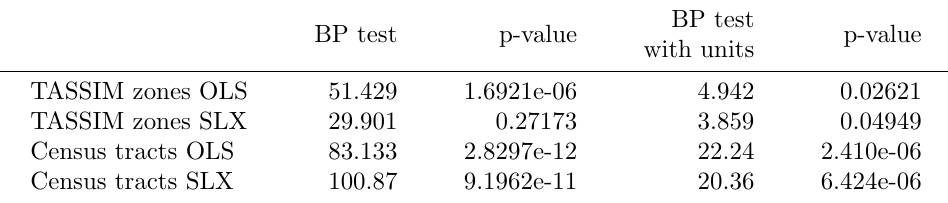
Figure A.5: Histograms of the distributions of counts of owner-occupied one-family housing units by observational unit; panel (a) observational units 506 Census tracts and panel (b) 96 approximate TASSIM zones. Table A.6: Studentized Breuch-Pagan tests for heteroskedasticity for models fitted by least squares for the 489 census tract data set and the 96 TASSIM zone data set; columns 3 and 4 test against unit counts per aggregate entity as the source of heteroskedasticity.